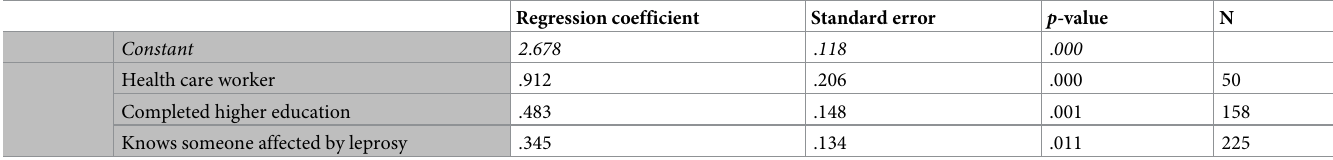
Table 3. Correlations between level of knowledge about leprosy and the other variables in the dataset. This model explained 16% of the variability of knowledge of lep- rosy (R-squared = 0.15).